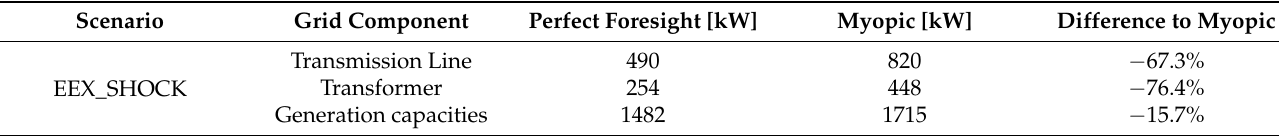
Table 9. Comparison of newly installed grid components and generation capacities of the EEX_SHOCK scenario. Scenario Grid